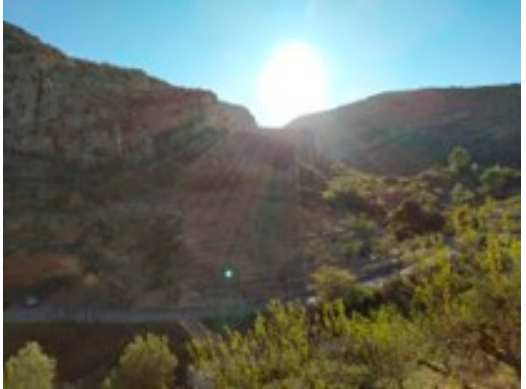
Figure 11. Concave shape, with “raised arms” on the side of the mountain in front of the shelter. The photo is taken by the author.